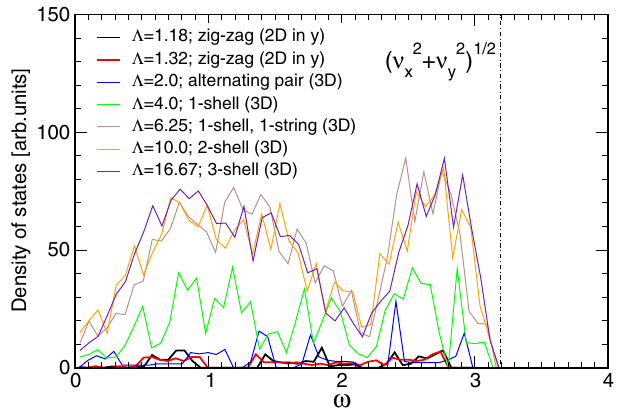
FIG. 4. (Color) Density of states evaluated under the smooth approximation for various 2D and 3D crystalline beams.